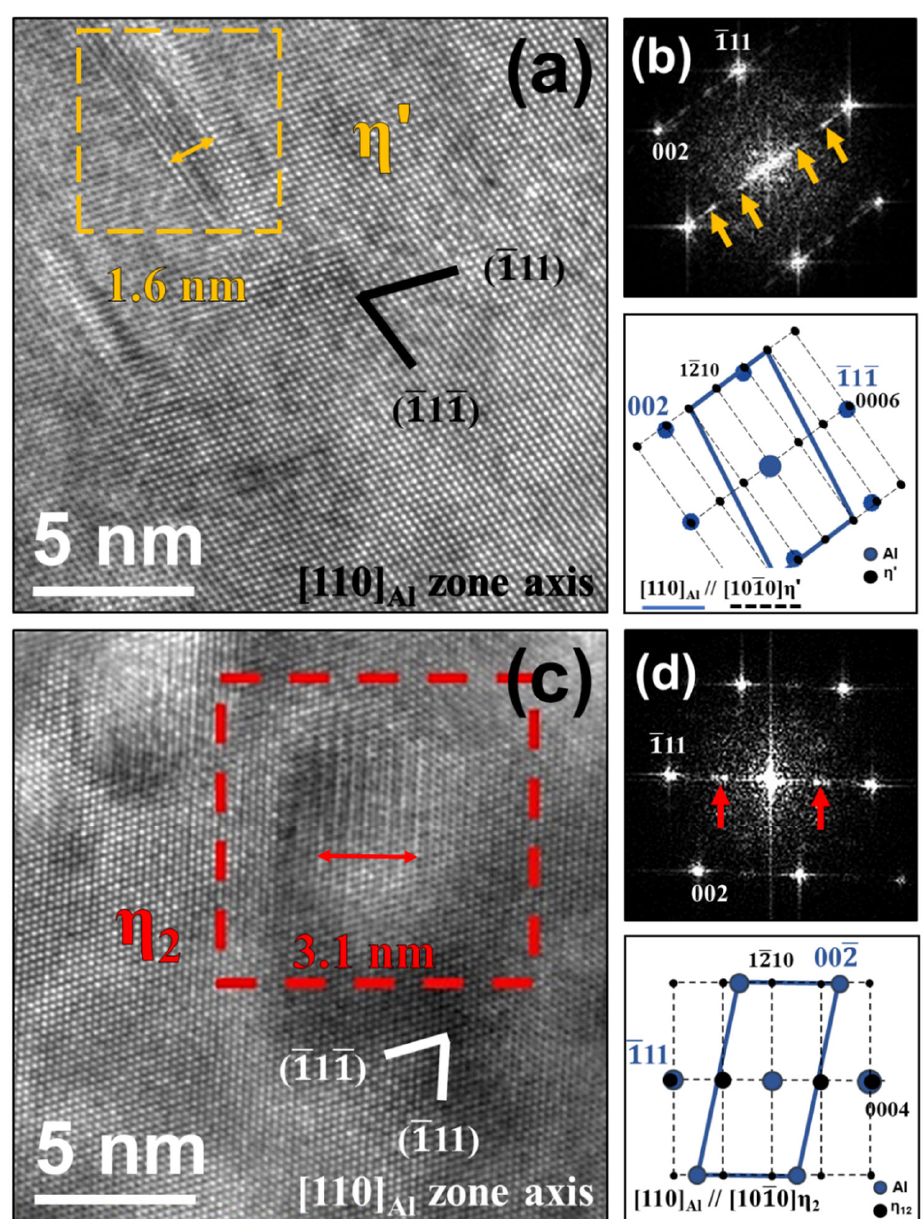
Figure 3. HR-TEM micrographs of ( a ) η ’ phase (yellow square) and ( c ) η 2 phase (red square) in NA-7d specimen ageing at 120 °C for 24 h observed along the [110] Al zone axis with their corresponding FFT diffractograms and simulated diffraction patterns, ( b , d ). The thickness of η ’ phase and η 2 phase were marked by yellow and red arrows, respectively.